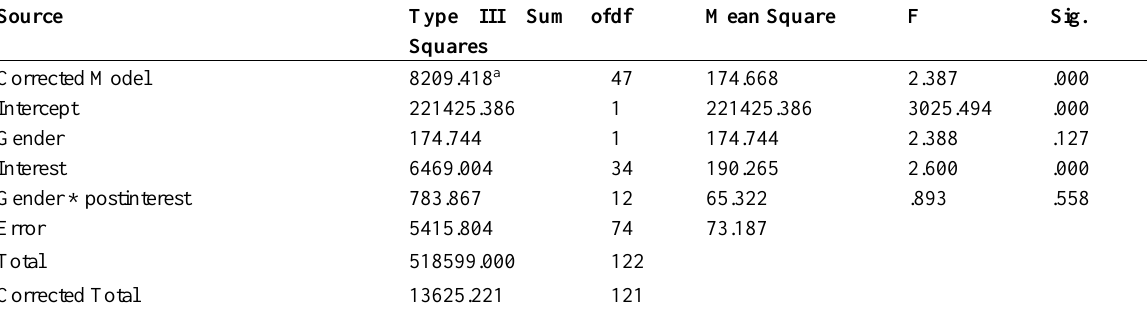
Table 4: Summary of Analysis of Covariance (ANCOVA) for Test of Significance of Effect of Treatments, Gender and Interaction Effect of Treatments Given to Students Taught with CBL And ABL and their Gender with Respect to their Mean Scores